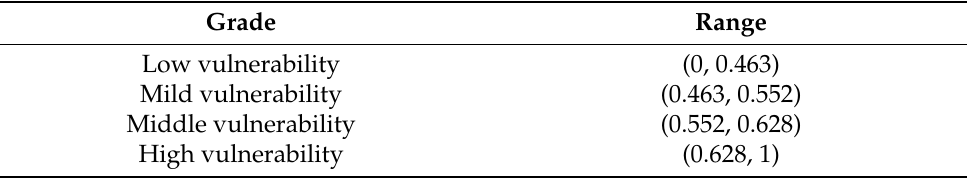
Table 5. Classification of agricultural drought vulnerability.